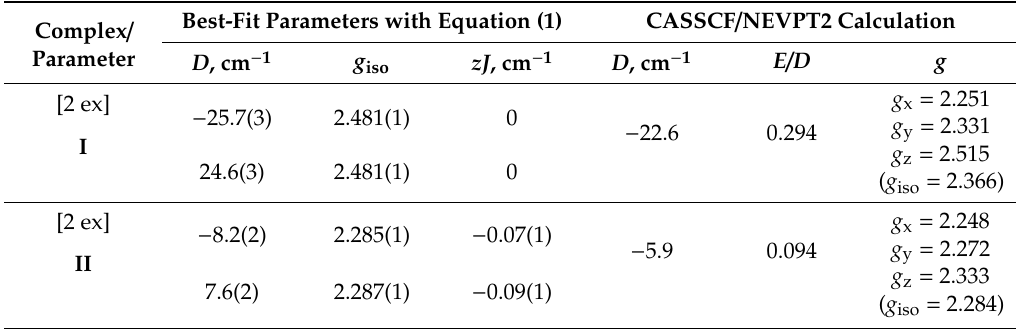
Table 2. Scalar D - and g -tensor parameters fitted with Equation (1) and CASSCF / NEVPT2 calculation for I and II.